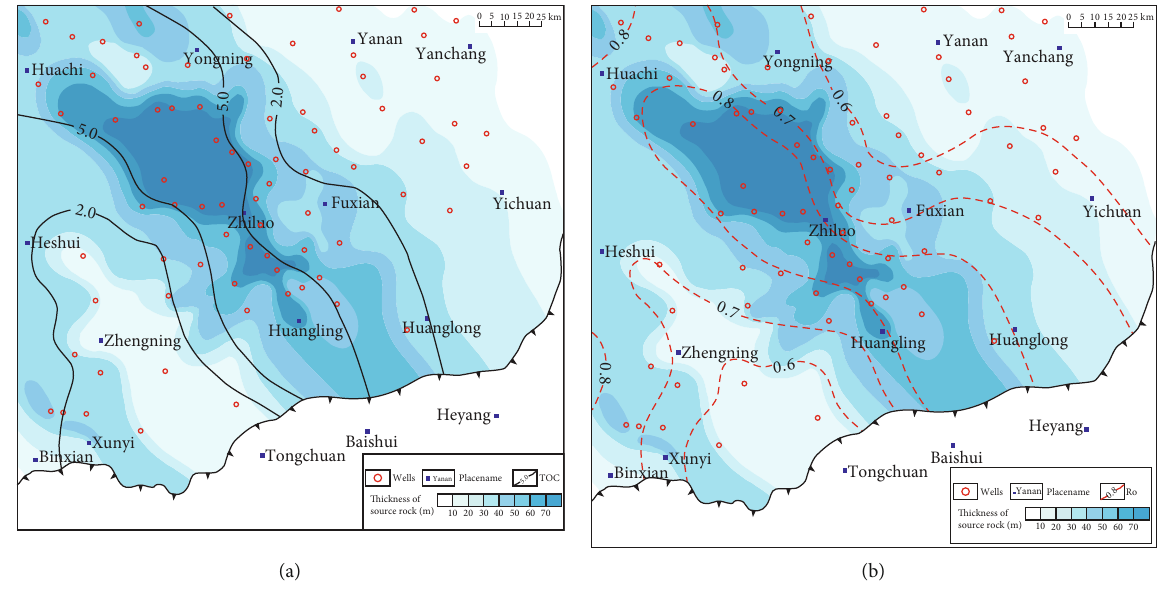
Figure 12: Thickness of source rocks and contour line of R o and TOC, Chang 7 interval, and southeastern Ordos Basin.